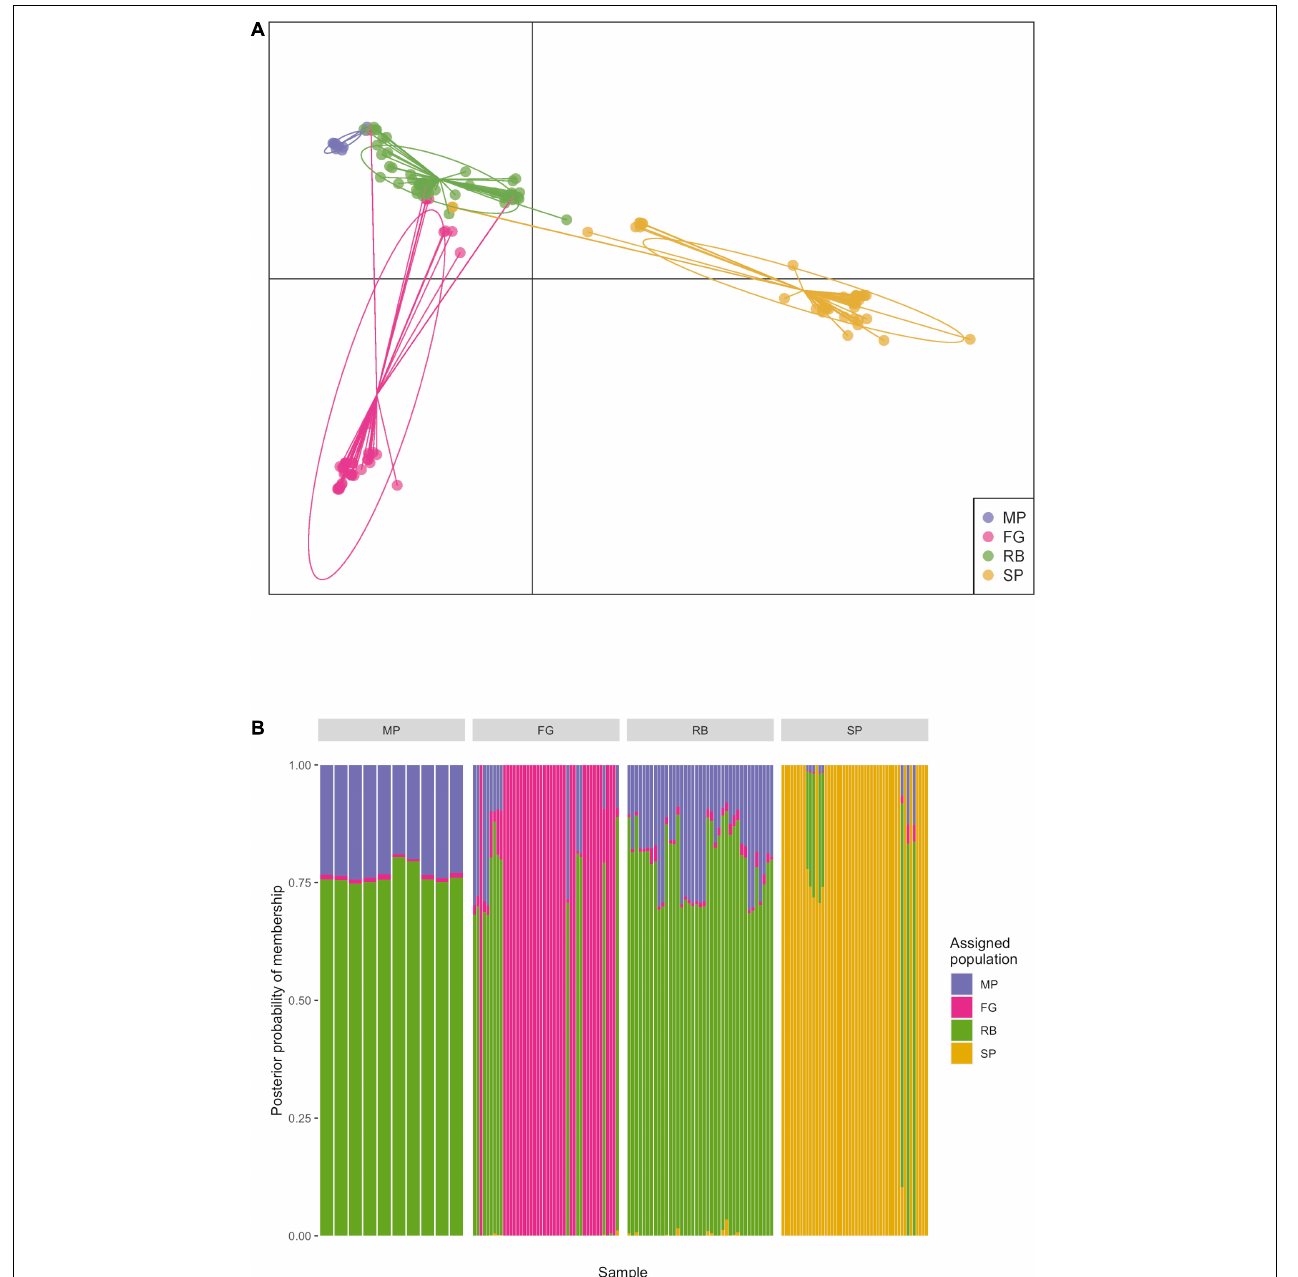
FIGURE 3 | Discriminant analysis of principal components (DAPC) performed with 154 Leptographium wageneri var. pseudotsugae isolates from four Oregon Douglas-fir plantations. Plantation was used as a priori population designation. (A) Scatter plot showing clusters representing each plantation with ellipses, (B) composition plot showing probability of membership of each isolate haplotype in each of four genetic clusters representing the Douglas-fir plantations.